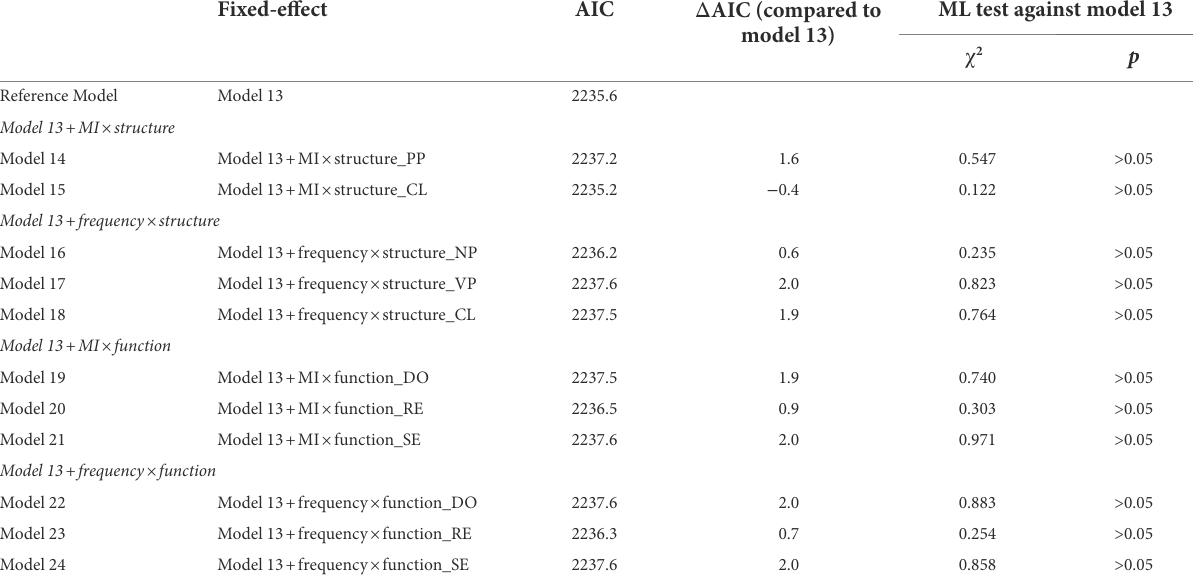
TABLE 2 Comparing model 13 to more complex